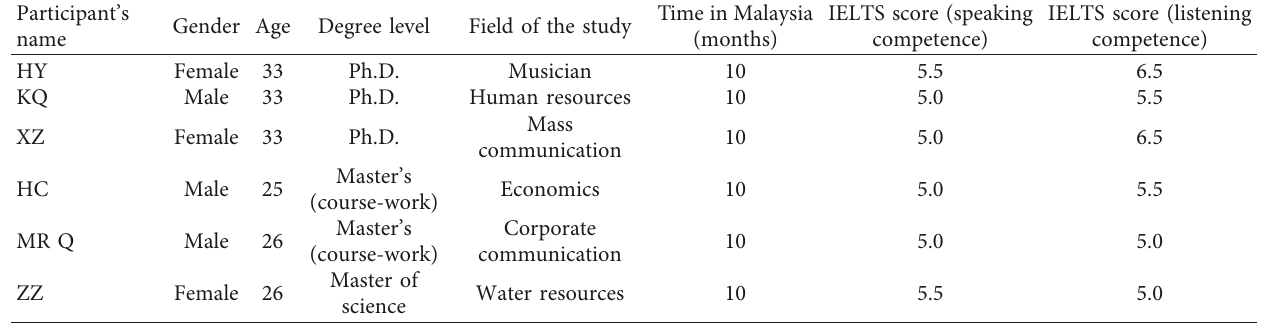
Table 1: Participants’ profiles.